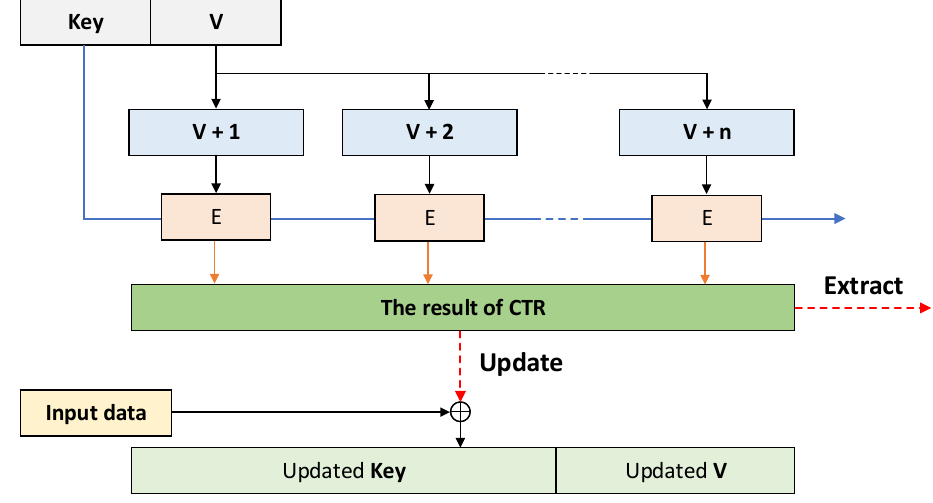
Figure 6. Update function and extract